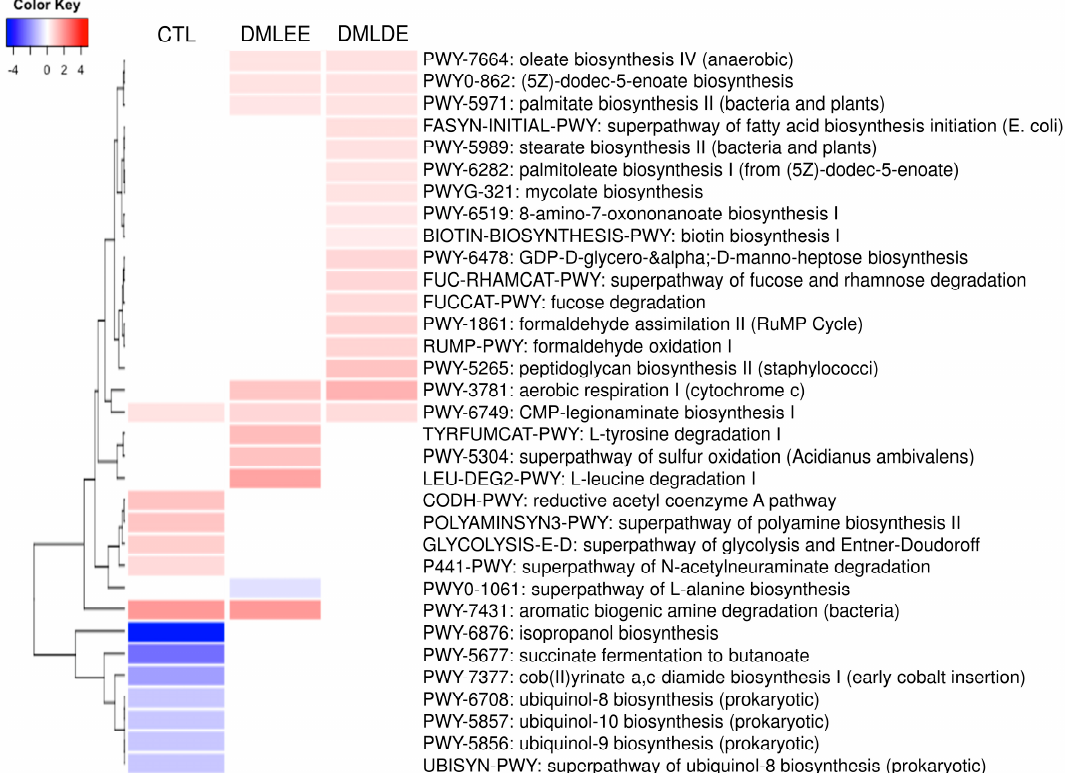
Figure 6. The relative abundance increased or decreased bacteria in OTU level in the comparison between ethanol and CTL or DML extracts. Abundance analysis was performed using linear discriminant analysis effect size (LEfSe). ( A ) Ethanol v/s CTL, ( B ) ethanol v/s DMLDE, ( C ) ethanol v/s DMLEE.